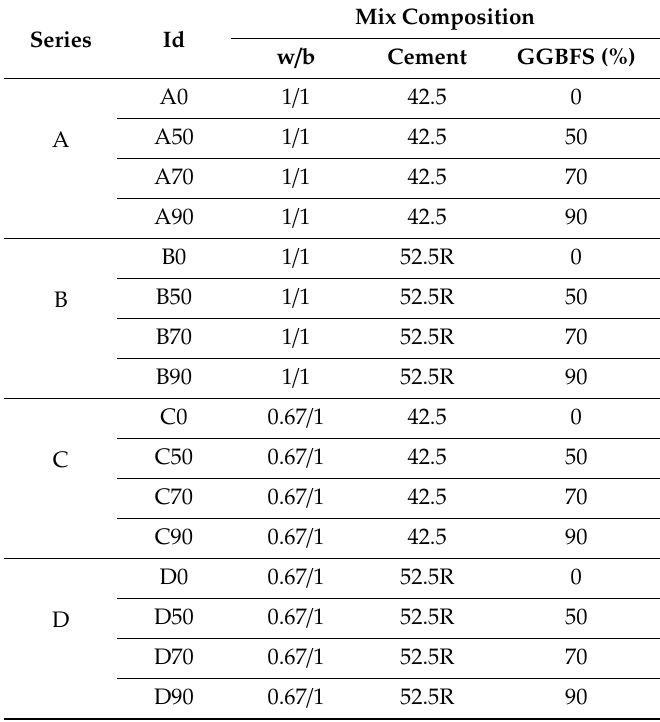
Table 2. Resume of mixtures identification.